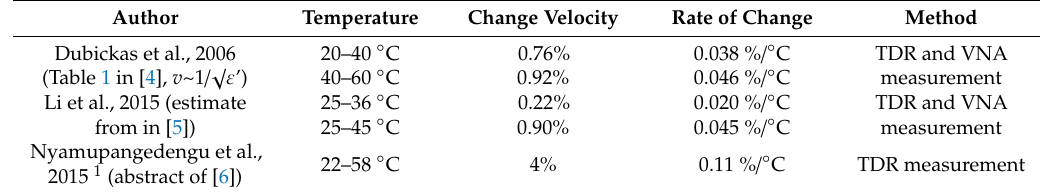
Table 1. Temperature dependency of signal propagation velocity based on time-domain reflectometry (TDR) and permittivity measurement by means of a vector network analyzer